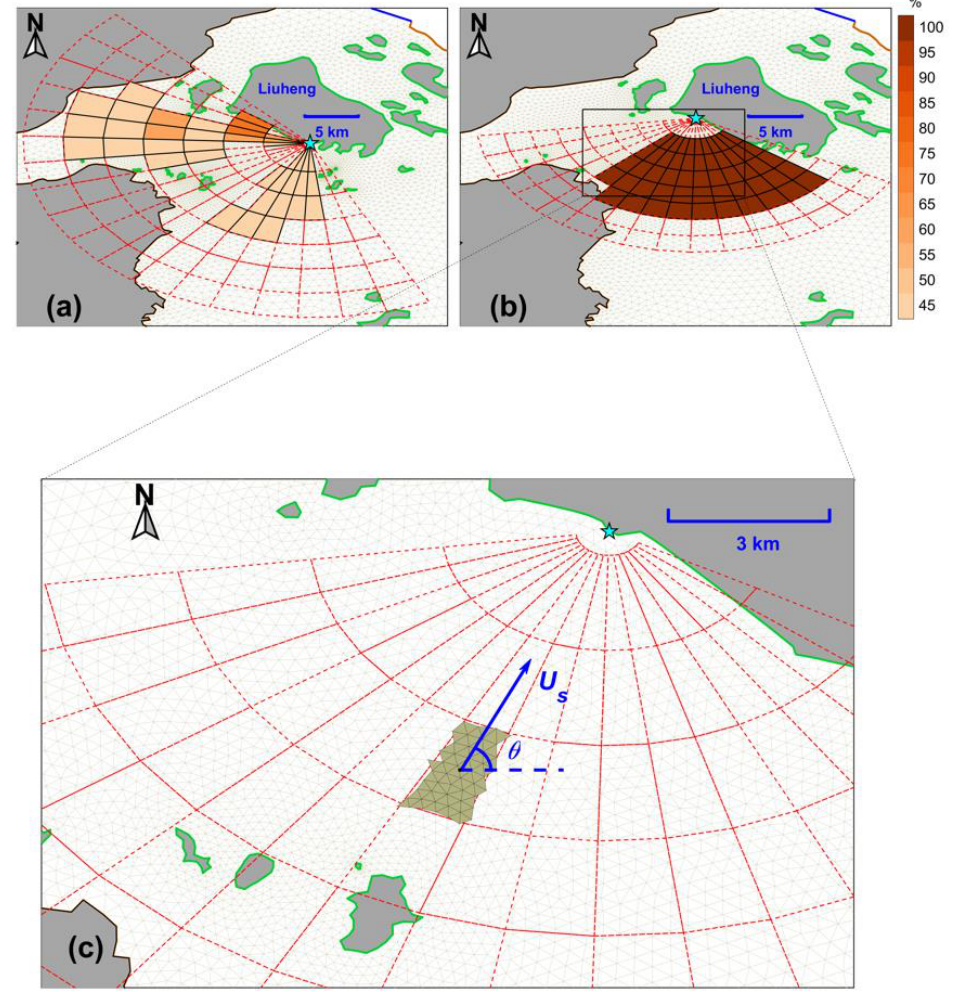
Figure 2. Observational sectorial area for high frequency ground wave radar (HFR) at ( a ) HF1 and ( b ) HF2. Each observational HFR unit is enclosed by red dashed lines. The filled elements represent the effective observational area for assimilation and the color denotes the data acquisition rate of each element. ( c ) An example of the relationship between HFR observation elements and the model triangular mesh. The direction of θ rotates anticlockwise from the east.